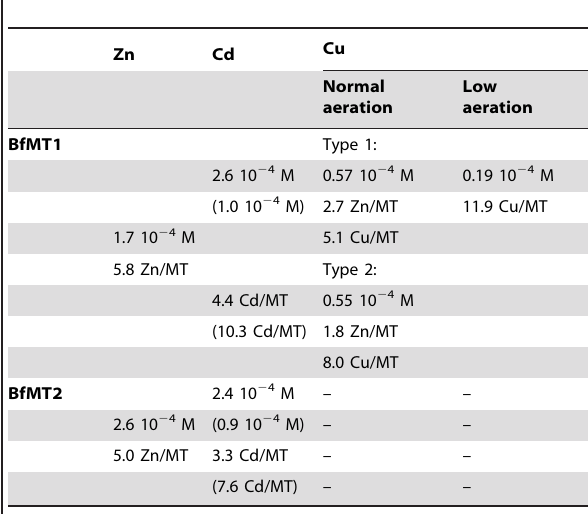
Table 1. Analytical characterization of the recombinant preparations of the Zn-, Cd- and Cu-complexes yielded by BfMT1 and